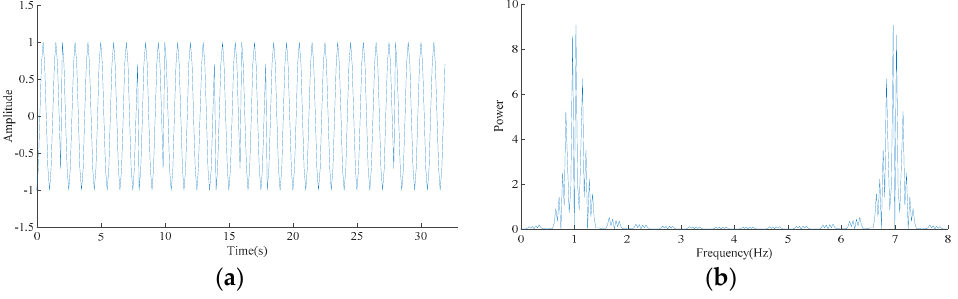
Figure 5. Bi-phase-coded pulse characteristic diagram: ( a ) time distribution; ( b ) frequency domain.